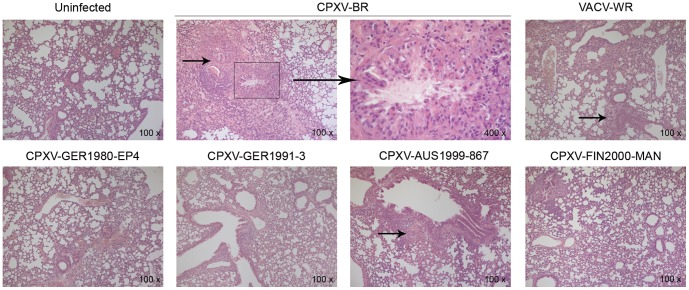
Lung tissue examinations at 7 dpi.While CPXV-BR, CPXV-AUS1999-867 and VACV-WR exhibited pneumonia, interstitial inflammation was observed with CPXV-GER1980-EP4. Many inflammatory cells, sometimes localized around the bronchioli, were noted upon infection with CPXV-FIN2000-MAN. Only few inflammatory cells were seen with CPXV-GER1991-3. The arrows head points at edema and collapse of the lungs. Magnification, 100 ×. Of note, eosinofilic cytoplasmic inclusions in the lung tissue of CPXV-BR-infected mouse are also shown (400 ×).